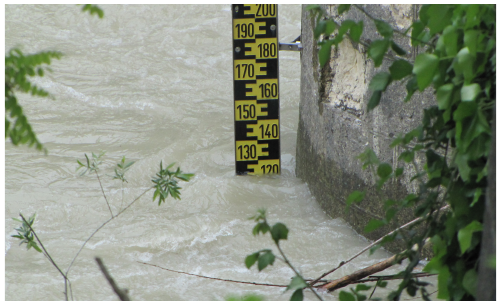
Acqualagna (PU), Candigliano basin. The hydrometric rod (also called staff gauge [5]) is made of